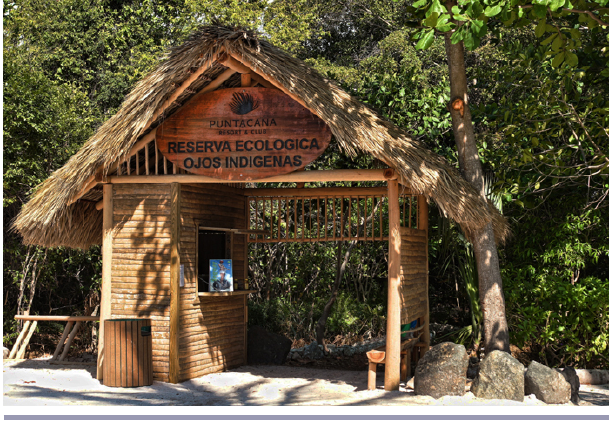
Fig. 2 . Entrance to the Indigenous Eyes Ecological